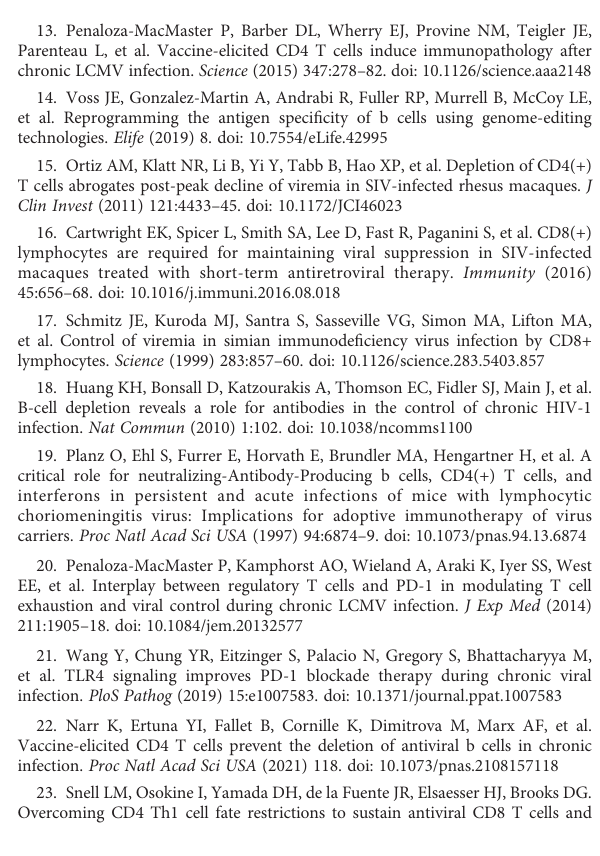
SUPPLEMENTARY FIGURE 2 CD8 T cells following co-transfer of B cells and CD4 T cells. Summary of LCMV-speci fi c (GP276-speci fi c) CD8 T cells in blood. Experiments were performed 3 times, n=3-5 mice per experiment. Error bars represent SEM. The p-values were calculated using Mann-Whitney test. ns, not signi fi cant.